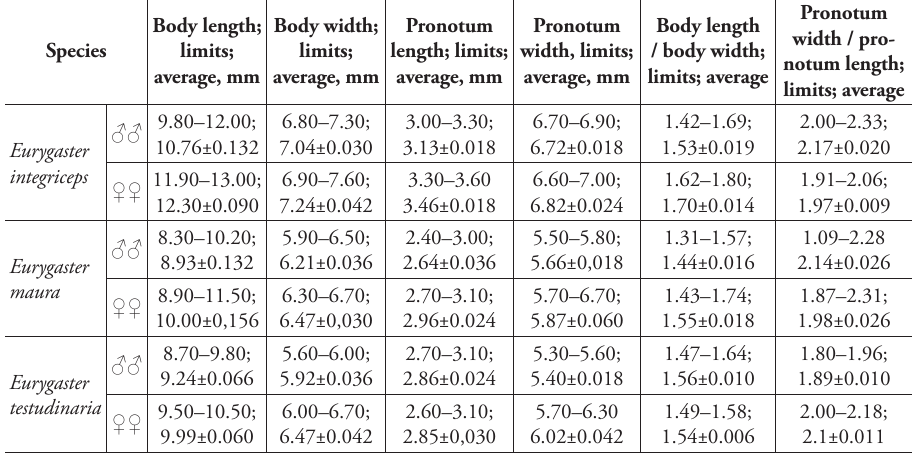
Table 3. Morphometric data of E. integriceps , E. maura, and E. testudinaria from Voronezh region.